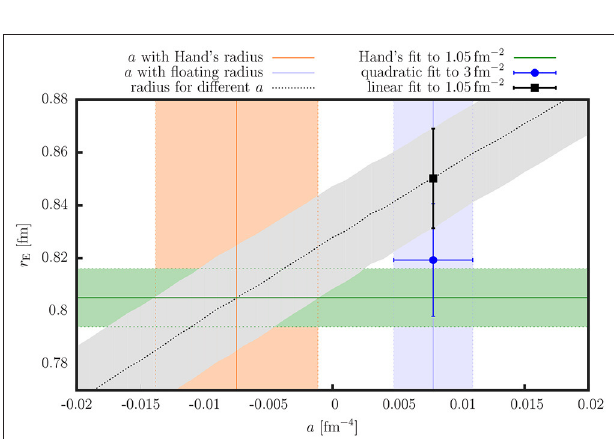
FIGURE 2 | The relation between parameters r E and a that determine the model (2). The green band denotes the original result of Hand et al. [ 2]. The blue point represents the result of the analysis when both parameters are free and the model is fitted to the data with Q 2 < 3.00fm − 2 . The vertical blue band indicates the value of the parameter a . The black point shows the final radius obtained by using the original two step approach of Hand et al. The gray line with the corresponding uncertainty shows how the extracted radius changes when a is modified from 0.02 to 0.02. The orange vertical band represents − the result of the fit when only a is being fitted, while the radius is kept fixed at 0.805(11)fm. The cross-section of green, orange, and gray bands defines the area of possible values of a considered in the original analysis of Hand et al. [2]. The obtained result supports the hypothesis that a mistake has been made in the original analysis and that a was considered with the wrong